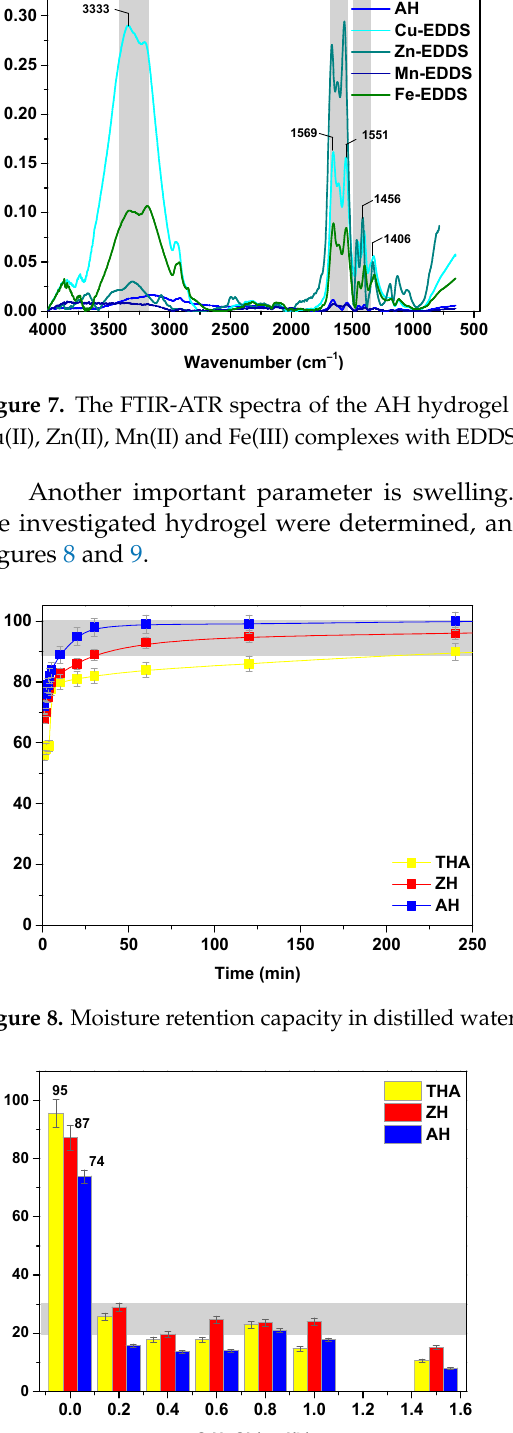
Figure 6. Grain size of THA, ZH and ZH. Additionally, the FTIR-ATR spectra of all of the hydrogels were measured before and after the adsorption process of Cu(II), Zn(II), Mn(II) and Fe(III) complexes with EDDS. In Figure 7, the characteristic AH bands, i.e., the stretching vibrations of the -CH 2 group at 1456 cm − 1 and the symmetric and asymmetric stretching vibrations of the carboxylate group at 1406 and 1551 cm − 1 , are presented.